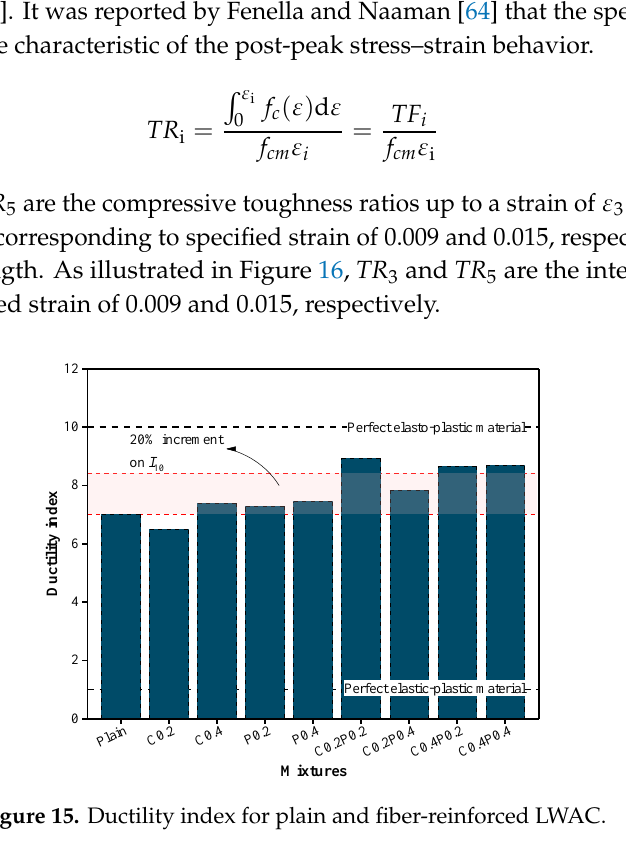
Materials 2020 , 13 , x FOR PEER REVIEW Figure 15. Ductility index for plain and fiber-reinforced LWAC. Figure 15. Ductility index for plain and fiber-reinforced LWAC.